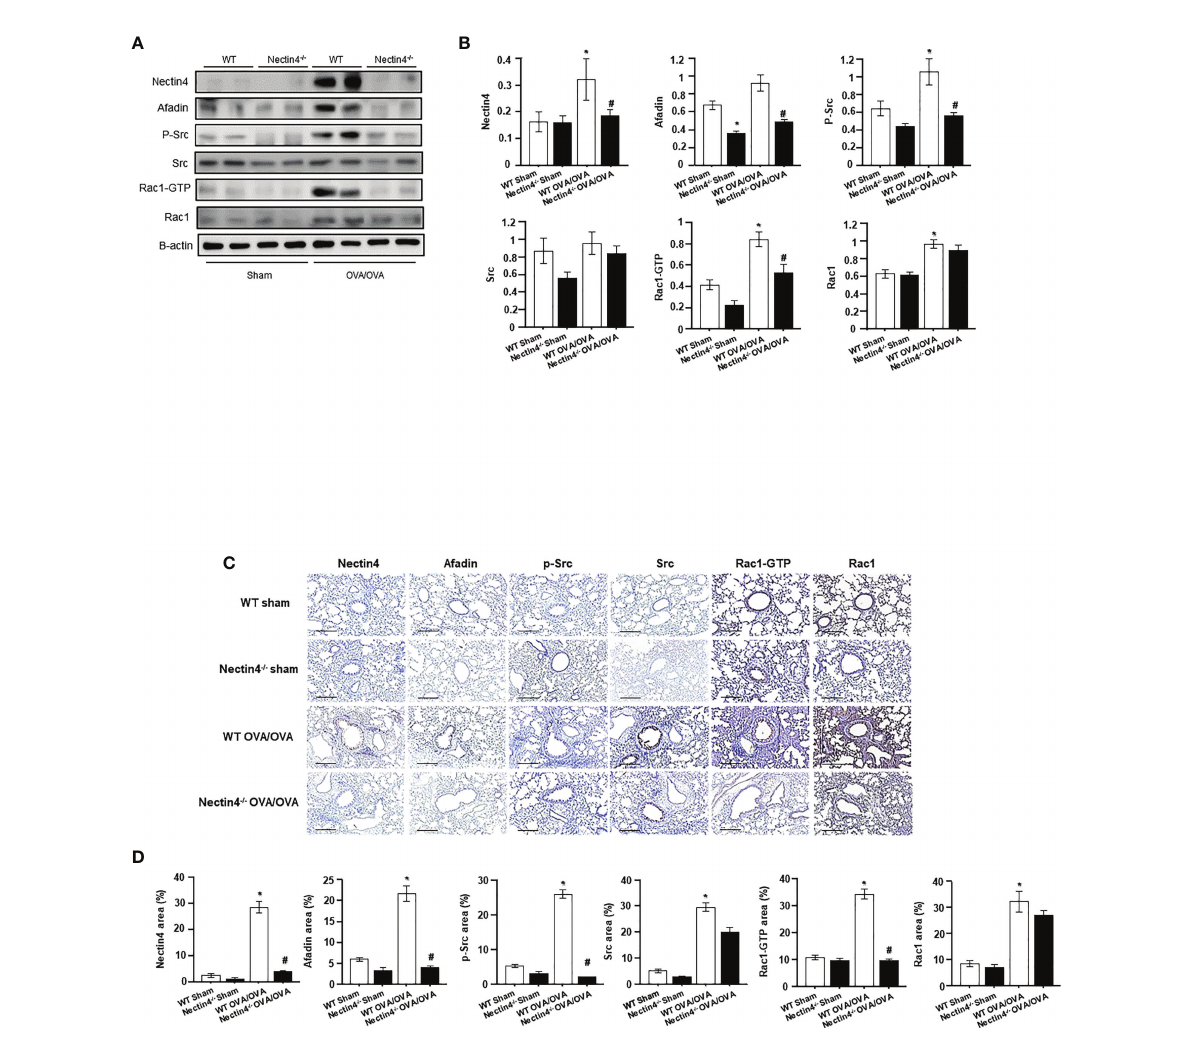
FIGURE 6 Absence of Nectin4 controls the expression of Afadin and the Src/Rac1 pathway. (A) Expression of the Nectin4/Afadin and the Src/Rac1 pathway in ovalbumin-induced asthma model of WT and Nectin4 -/- mice. (B) Densitometry of the bands obtained on three different individuals western blots. The values were normalized to those of b -actin and are expressed as the mean ± SEMs (n = 6-10 mice/group). (C) The lung tissues of OVA-sensitized/ challenged mice were analyzed for Nectin4/Afadin and Src/Rac1 pathway expression by immunohistochemical staining (scale bar = 50 m m). (D) Quanti fi cation of percentage of Nectin4/Afadin and Src/Rac1 pathway protein-positive areas. All quantitative analyses were performed using ImageJ software. The results are representative of at least 3 independent experiments. * p<0.05 vs. WT sham. #p<0.05 vs. WT